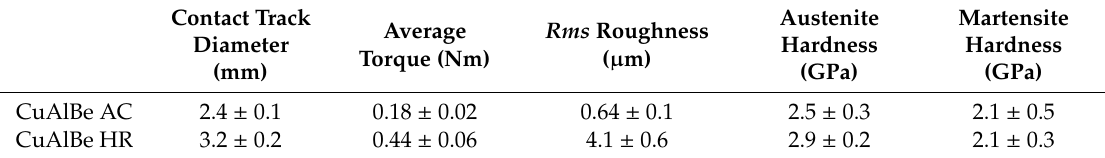
Table 1. Average and standard deviation of measured variables as determined from 5 surface modification tests on AC and 5 tests on HR.